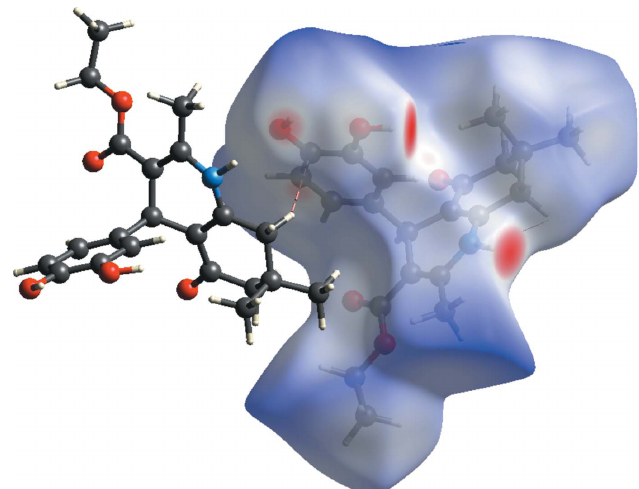
Figure 11 Hirshfeld surface of III mapped over d norm . Short and long contacts are indicated as red and blue regions, respectively. Contacts with distances approximately equal to the sum of the van der Waals radii are colored white. The close contact between H8 A and C20 is shown as a dashed line.